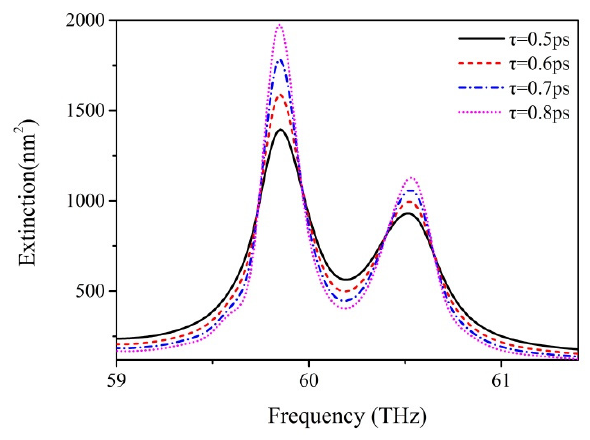
Figure 6. The extinction spectra of graphene hexamer with different momentum relaxation time τ . The two peaks become higher and Fano ‐ like dip becomes deeper with increasing τ .